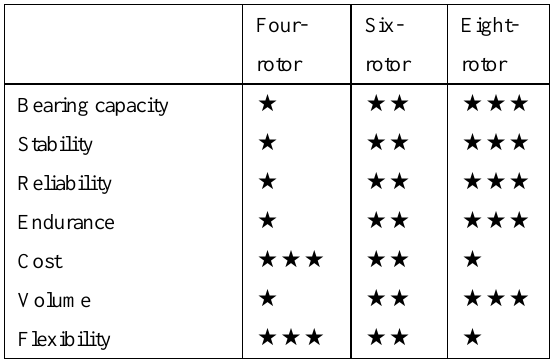
Table 1 Comparison of related factors of multi-rotor